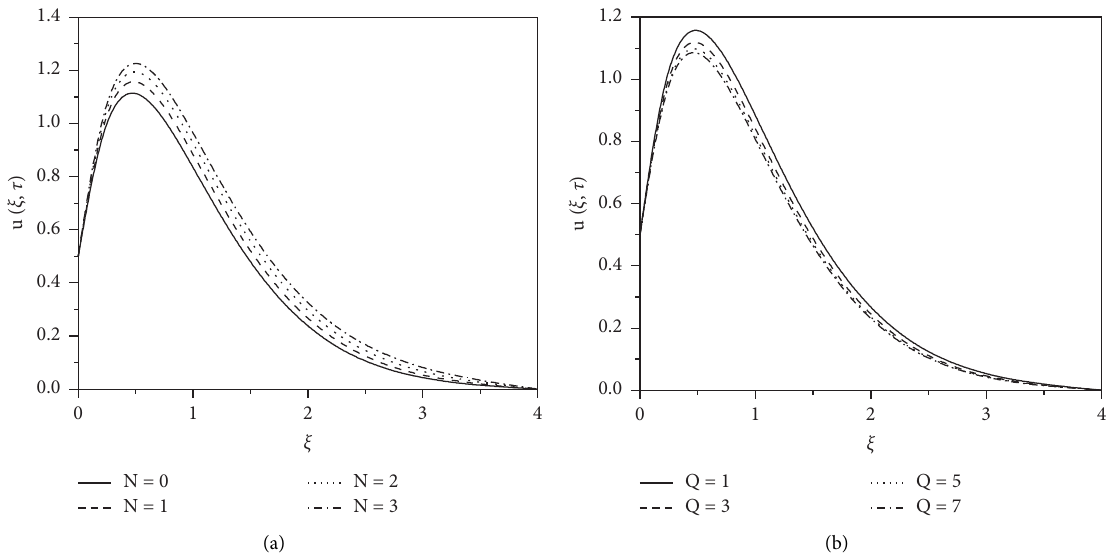
Figure 12: Variation of velocity u ( ξ , τ ) against ξ in the limiting case for various values of (a) N